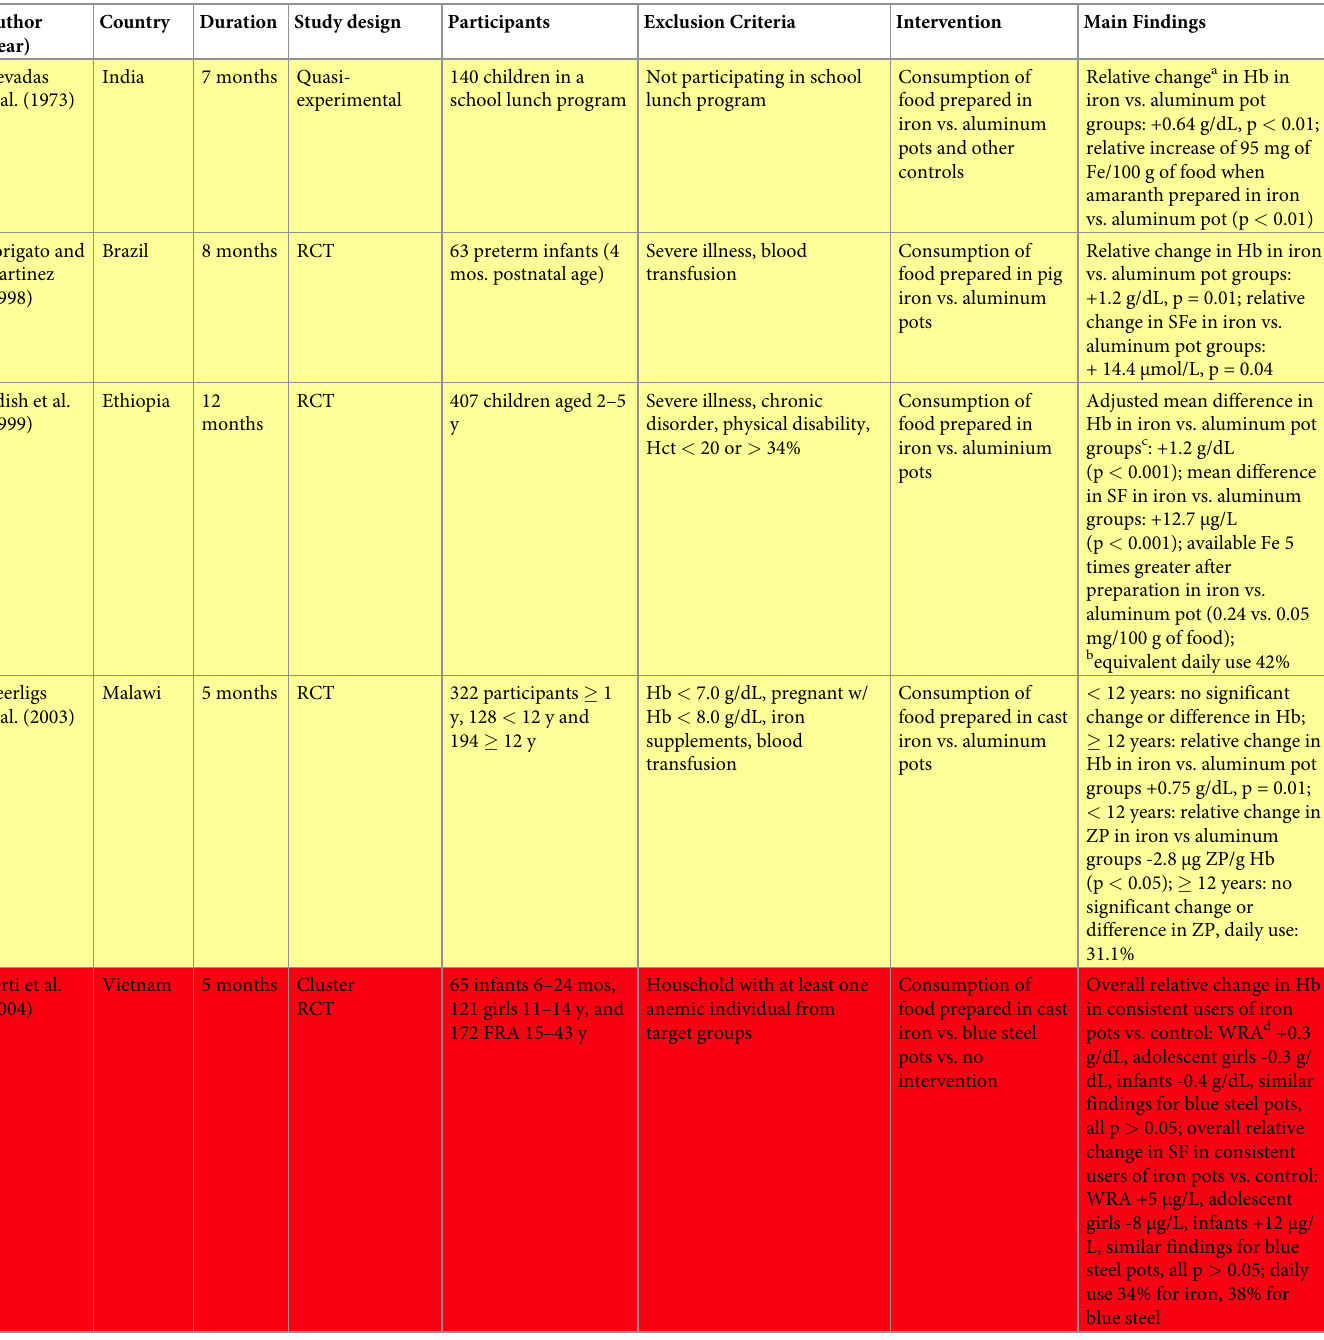
Table 1. General characteristics and outcomes of included studies (Green: High quality, Yellow: Moderate quality, Red: Low